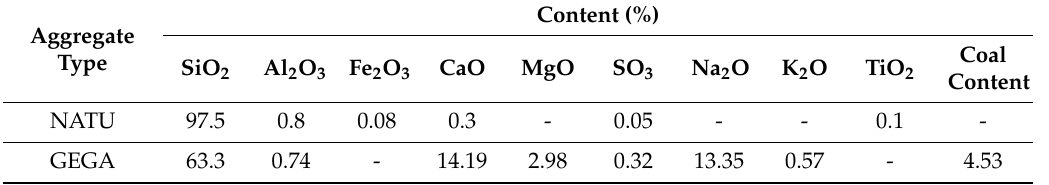
Figure 3. Aggregate NATU ( a ) grains to 4 mm; ( b ) grain surface, 100×; ( c ) grain structure after cutting the sample (grain in the vicinity of cement paste), 1000×.